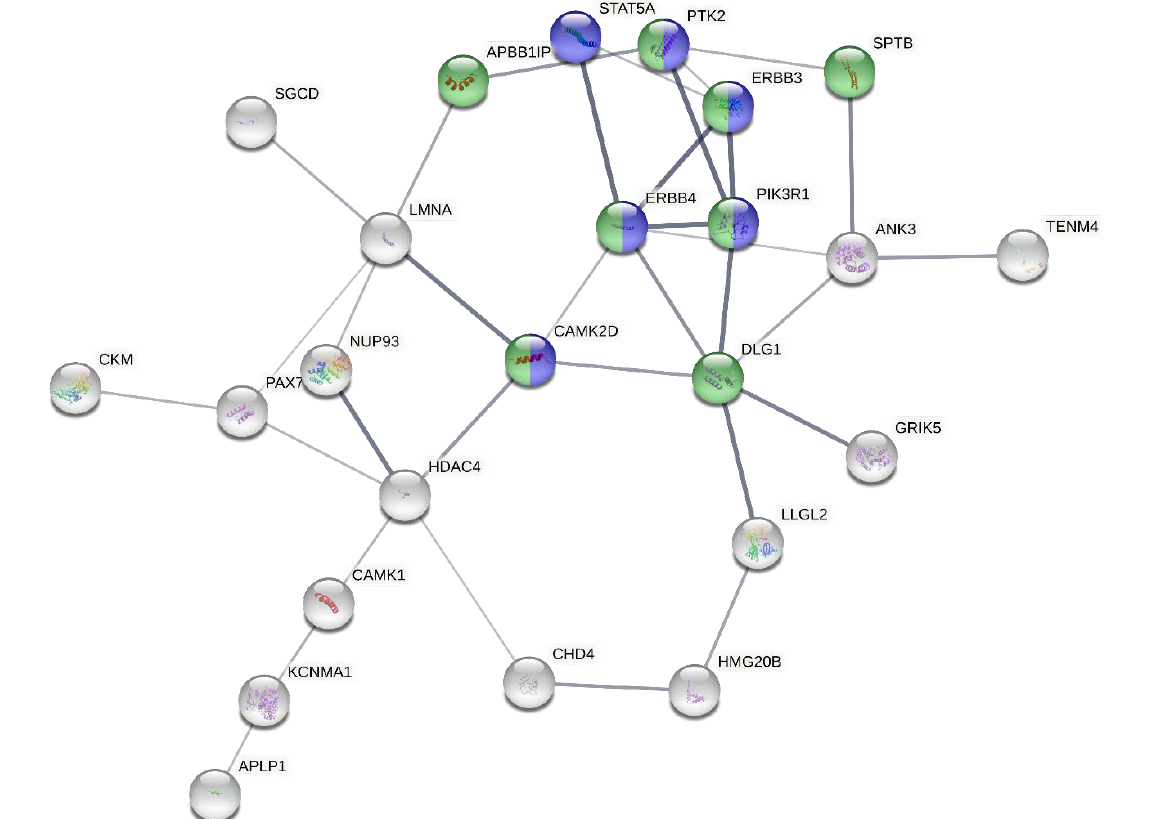
Figure 3. Protein interaction network of genes with upstream and 5′ UTR variants generated by STRING. Green color in the nodes represents ErbB pathway involvement and blue represents the MAPK pathway. The density of the connecting lines between the protein nodes in the figure represents the interaction score, highlighting the importance of the MAPK and ErbB pathway-related proteins.